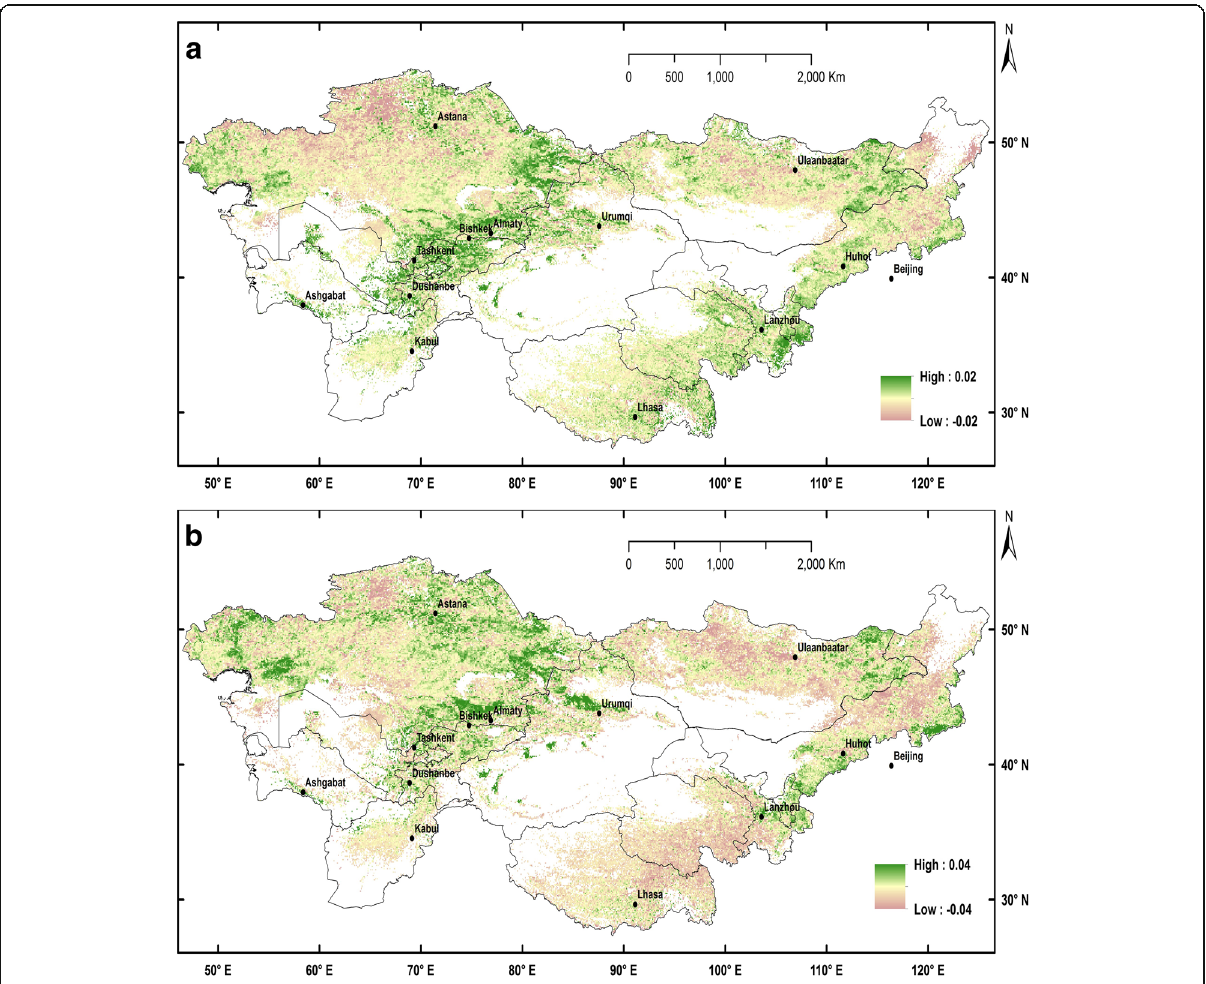
Fig. 3 The changes in forage proxies (or total amount of green biomass) during 1981 – 2013 based on Advanced Very High Resolution Radiometer (AVHRR) satellites. a is the trend of mean NDVI (Normalized Difference Vegetation Index), which may indicate forage, whereas b is the change in maximum NDVI over